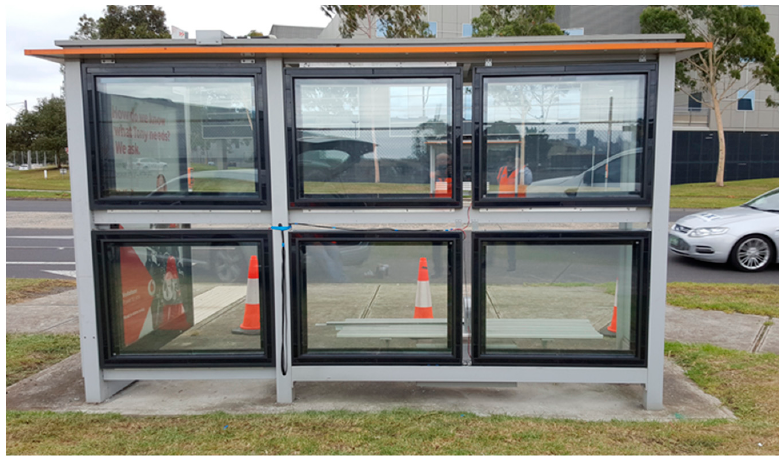
Figure 9. Solar window-powered bus stop installed by Adshel, Inc. (Melbourne, Australia).